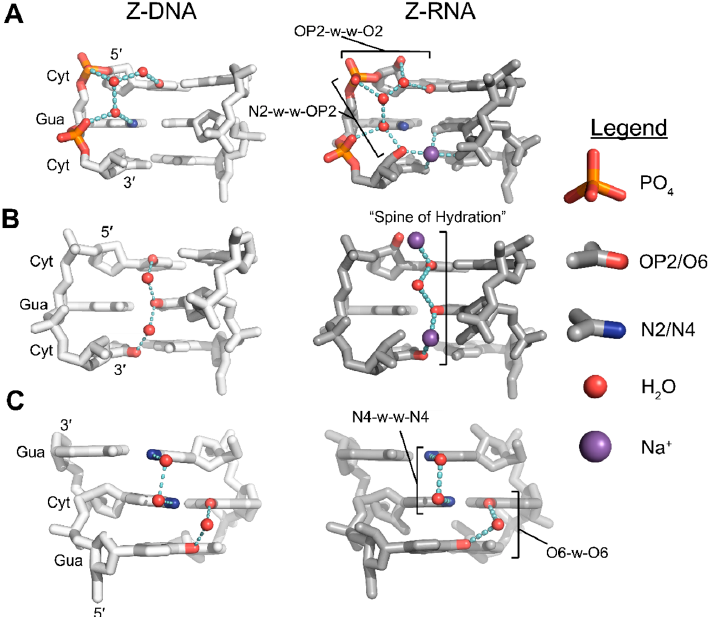
Figure 5. Hydration of the Z-conformation plays a significant role in its stabilization. Hydrogen bonding networks facilitated by exocyclic groups of alternating purines and pyrimidines to the phosphate backbone within the minor groove in Z-DNA (PDB: 1ICK [70], left A , B , C ) and Z-RNA (PDB: 2GXB [10], right A , B , C ). ( A ) Guanine N2 amino groups are involved in hydrogen bonding networks to both the 5 ′ phosphate of the following residue (N2-w-OP2) or to its 5 ′ phosphate (N2-w-w-OP2). Cytidine O2 groups are involved in hydrogen bonding networks to 5 ′ phosphates of the following residue through two water molecules (O2-w-w-OP2) or to guanine N2 groups through one water (O2-w-N2). In Z-RNA, the 2 ′ OH is within hydrogen bonding distance to stabilize the networks through additional hydrogen bonds. ( B ) Spine of hydration for Z-DNA ( left ) and Z-RNA ( right ). Water molecules are positioned between the base plane and were thought to facilitate hydrogen bonds between successive cytidine residues of opposite strands. In the Z-RNA crystal structure, every other water molecule is replaced by Na + , reducing H-bond length and resulting in a narrowing of the minor groove. ( C ) Hydration of the major groove surface for Z-DNA ( left ) and Z-RNA ( right ). Two water molecules bridge N4 groups of adjacent cytosine residues on opposite strands. One water molecule bridges O6 atoms of adjacent cytosine residues on opposite